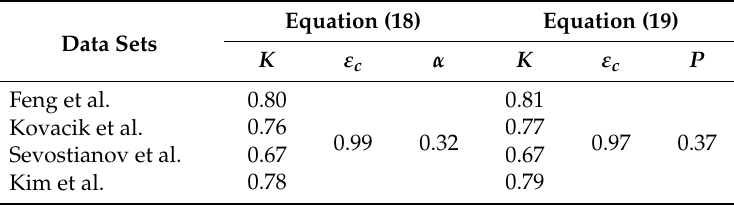
Table 6. Coefficient of the new models: Equations (18) and (19), for closed-cell metal foams. Data